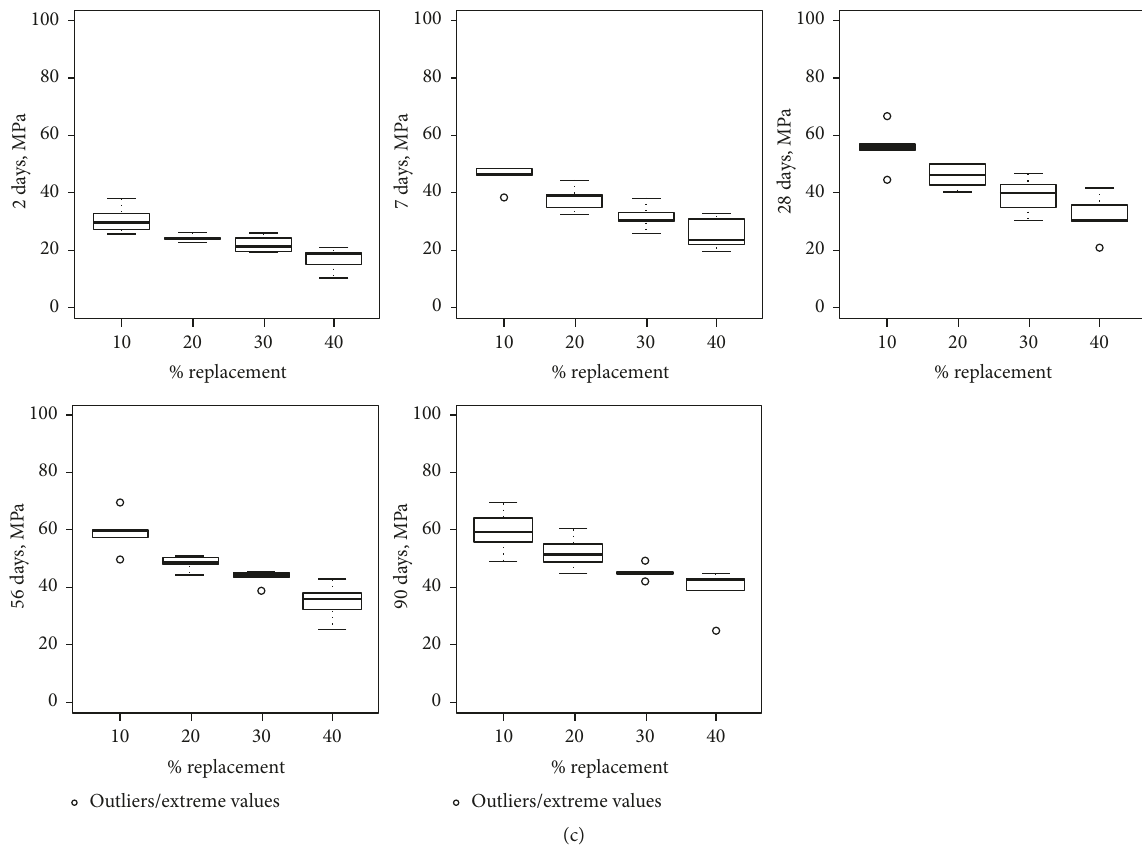
Figure 8: Compressive strength of blended cement versus percent replacement: (a) scoria, (b) pumice, and (c) RHA.